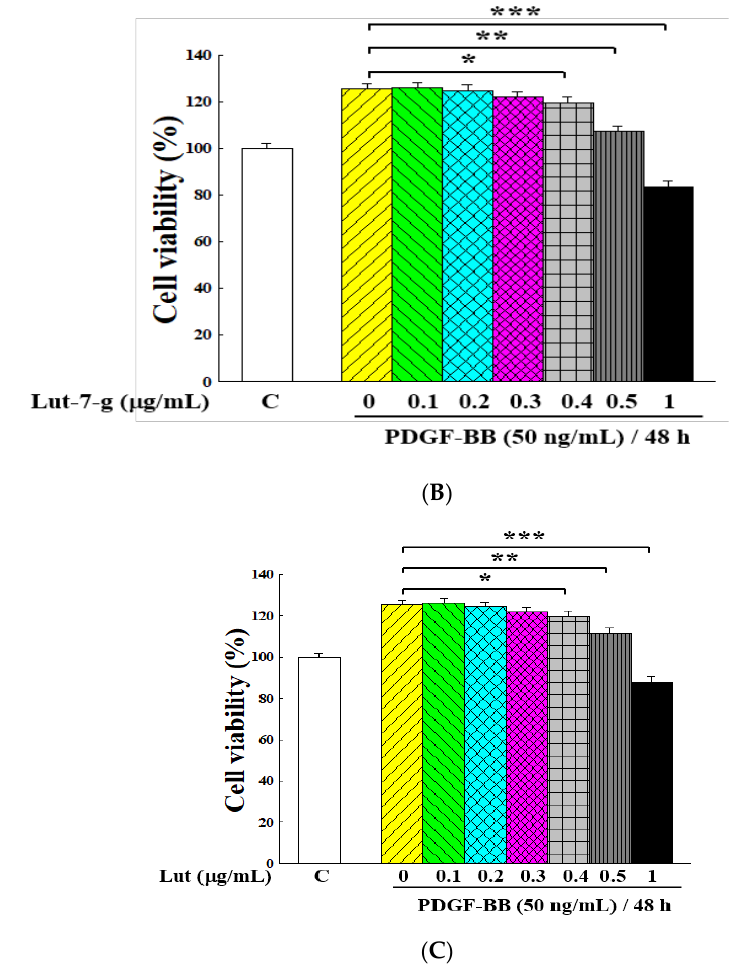
Figure 7. Inhibitory effects of the main GT ingredients on the proliferation of PDGF-BB-stimulated VSMCs: CGA ( A ), lut-7-g ( B ), and lut ( C ). The cell proliferation was conducted under the stimulation of 50 ng/mL of PDGF-BB for 48 h. The cell viability was measured by an MTT assay kit, and the number of cells was regarded as 100% with PDGF-BB stimulation and without sample treatment. Group C was the VSMC growth without PDGF-BB stimulation and sample treatment. Data were estimated from five replicate experiments. Significant di ff erences compared with the vehicle (group 0) are denoted as * p < 0.05, ** p < 0.01, and *** p <